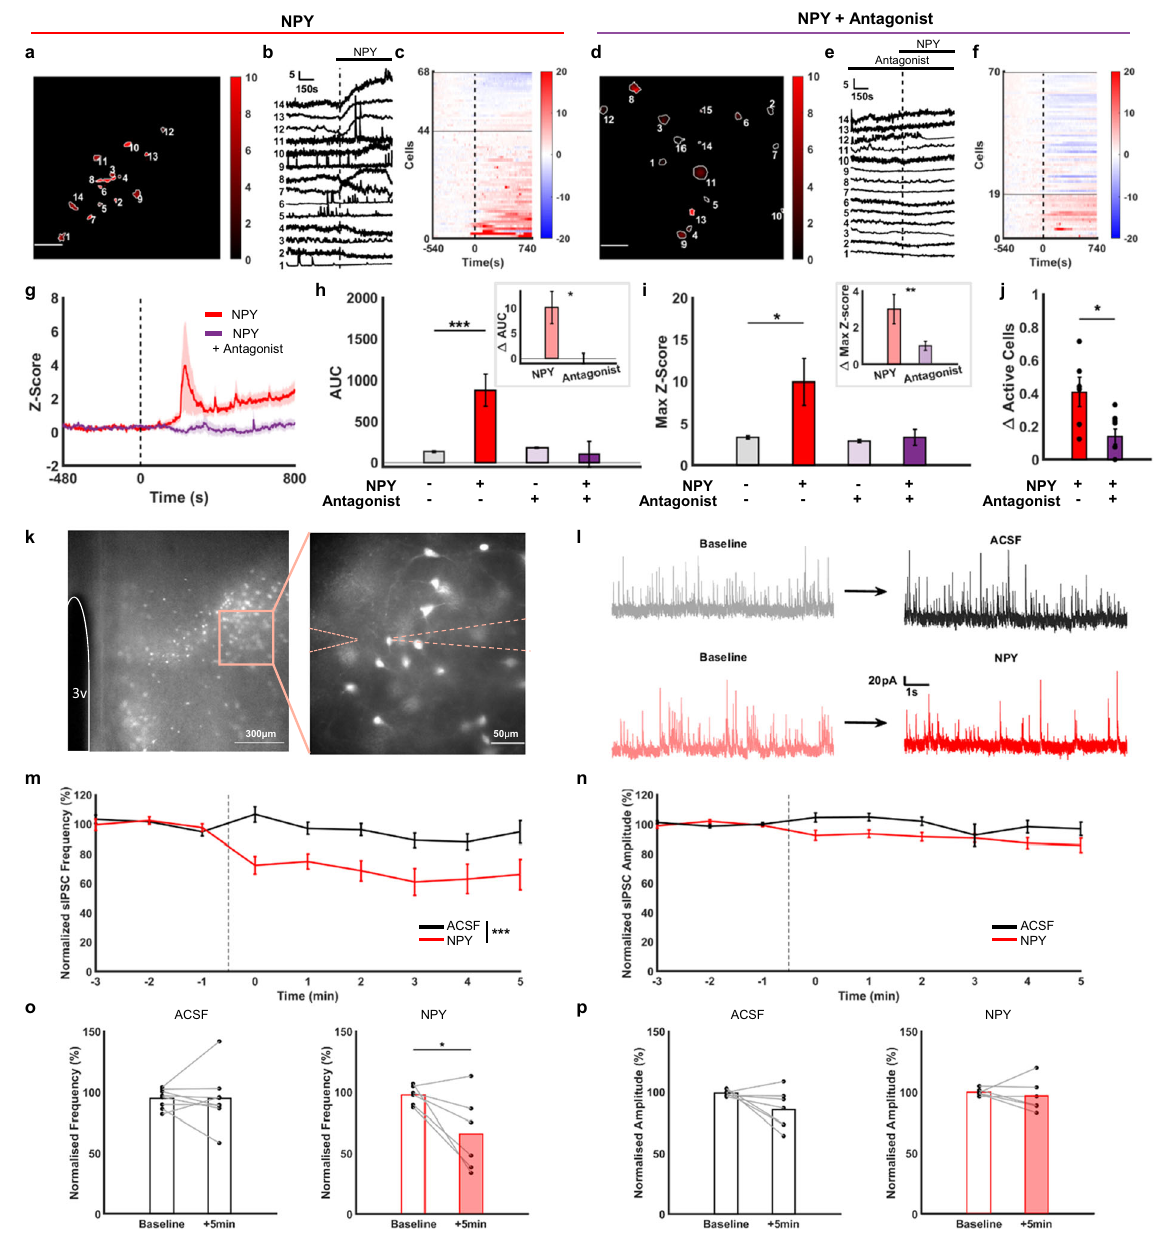
Fig. 6 | NPY increases LepR neuron activity via disinhibition of GABAergic interneuron in the LH. a , d Representative image of GCaMP6s-expressing LH LepR neurons during the application of NPY( a ) or NPY+Antagonist( d )using brain slice calcium imaging. The degree of colour brightness represents the degree of cell activity(maxZ-score).Scalebar:50 μ m.Theexperimentwasrepeated7times( a